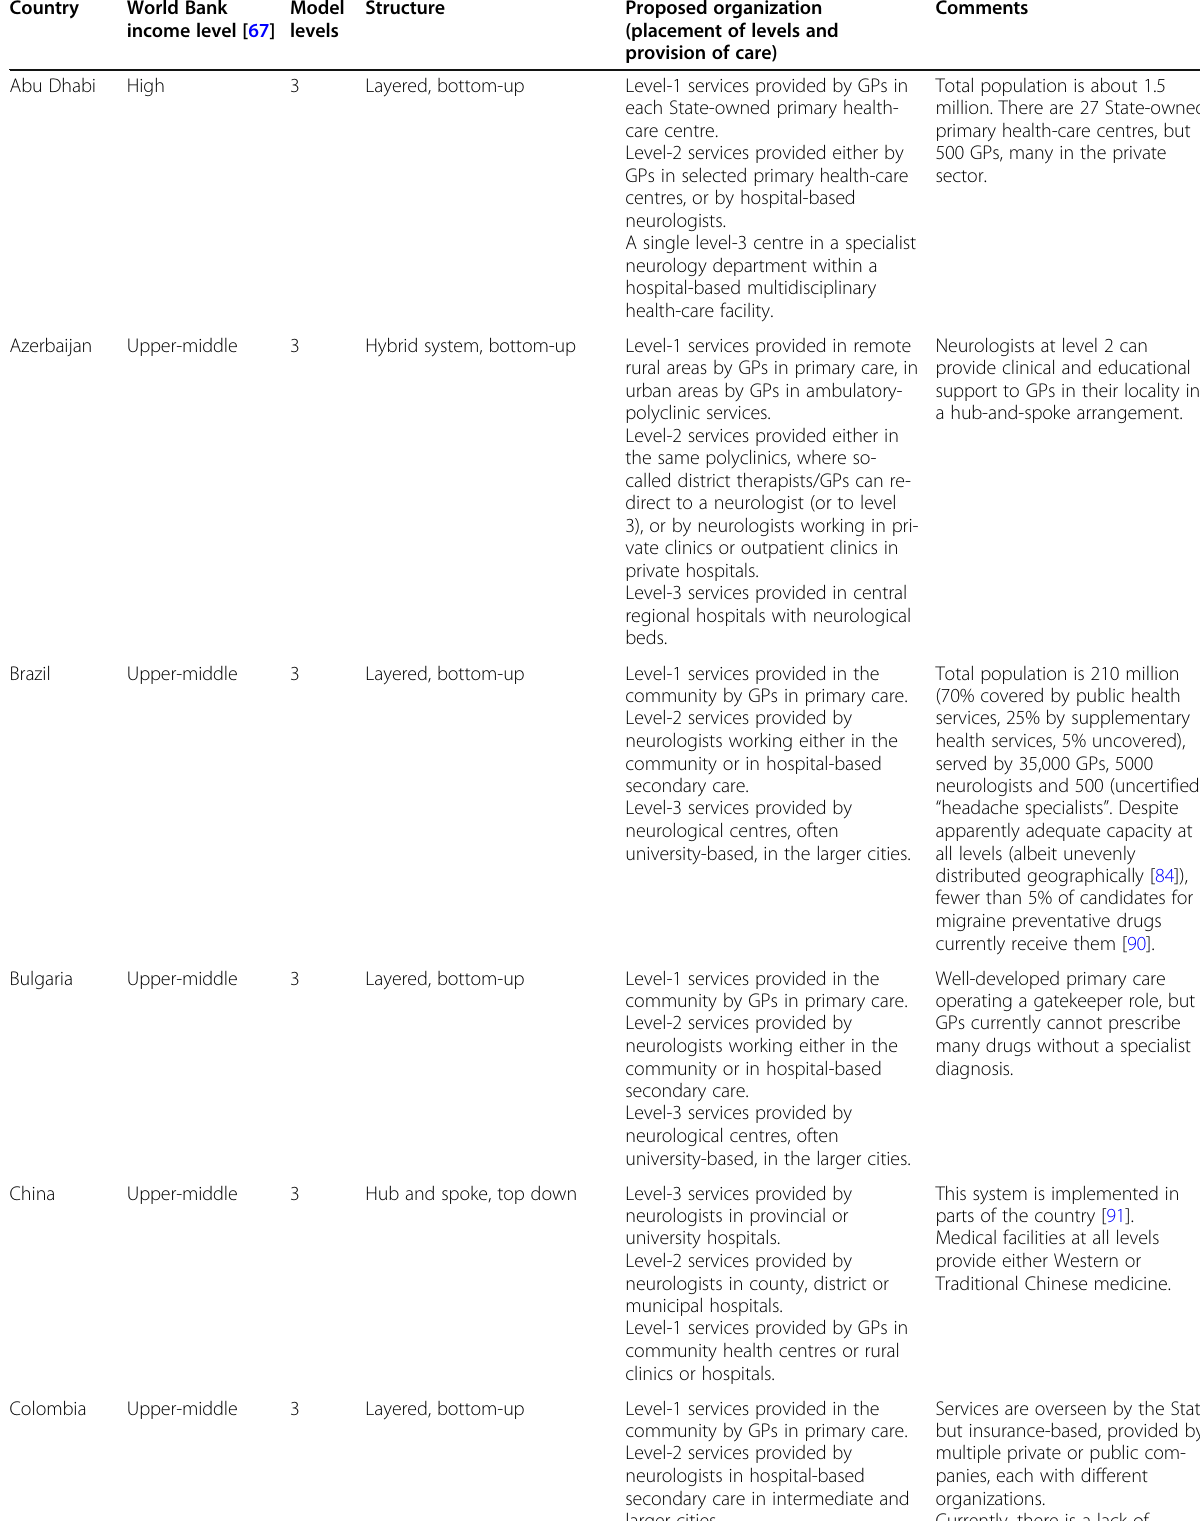
Table 7 Illustrations of how the model might be implemented, with adaptations, in various countries